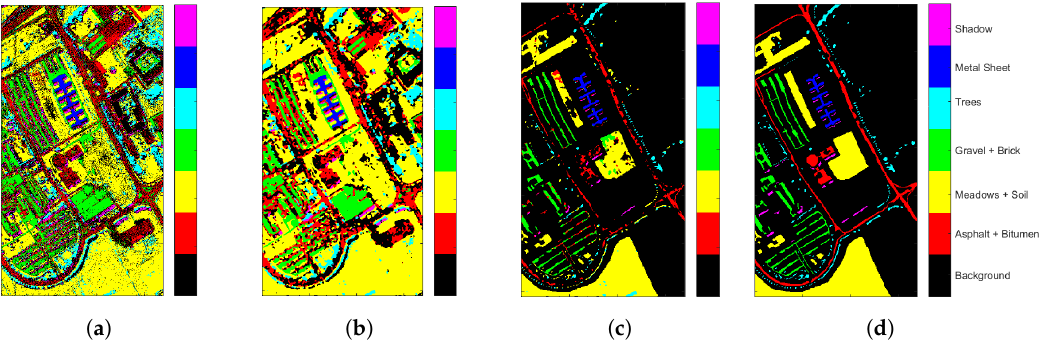
Figure 28. Classification maps for Pavia: ( a ) classification map generated using winner takes it all with 50% threshold; ( b ) median filtered classification map; ( c ) classification map in ( b ) after masking non-assigned or background pixels in the reference data; ( d ) modified reference classification